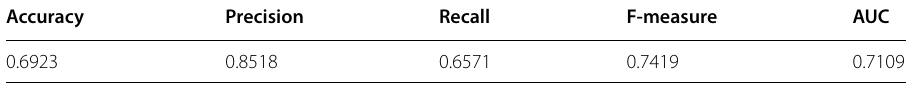
Table 6 Performance of the LSTM on the StockTwits dataset Accuracy Precision